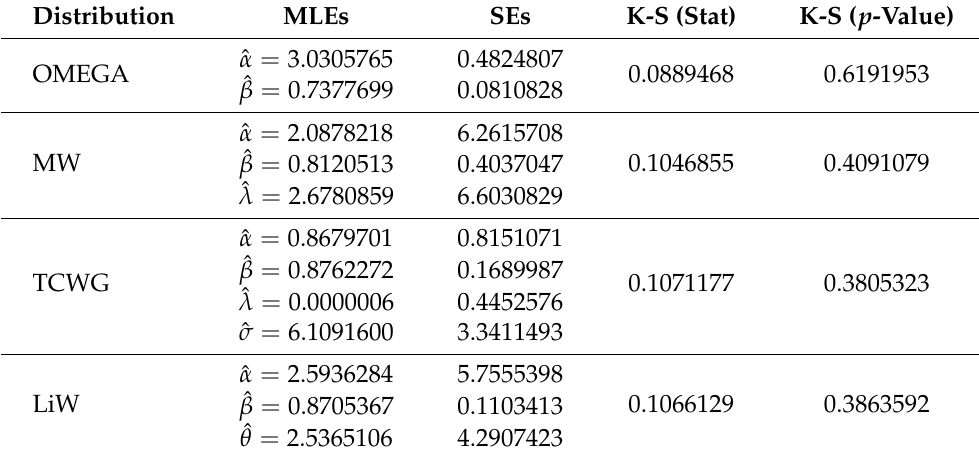
Table 8. Results from the fitted